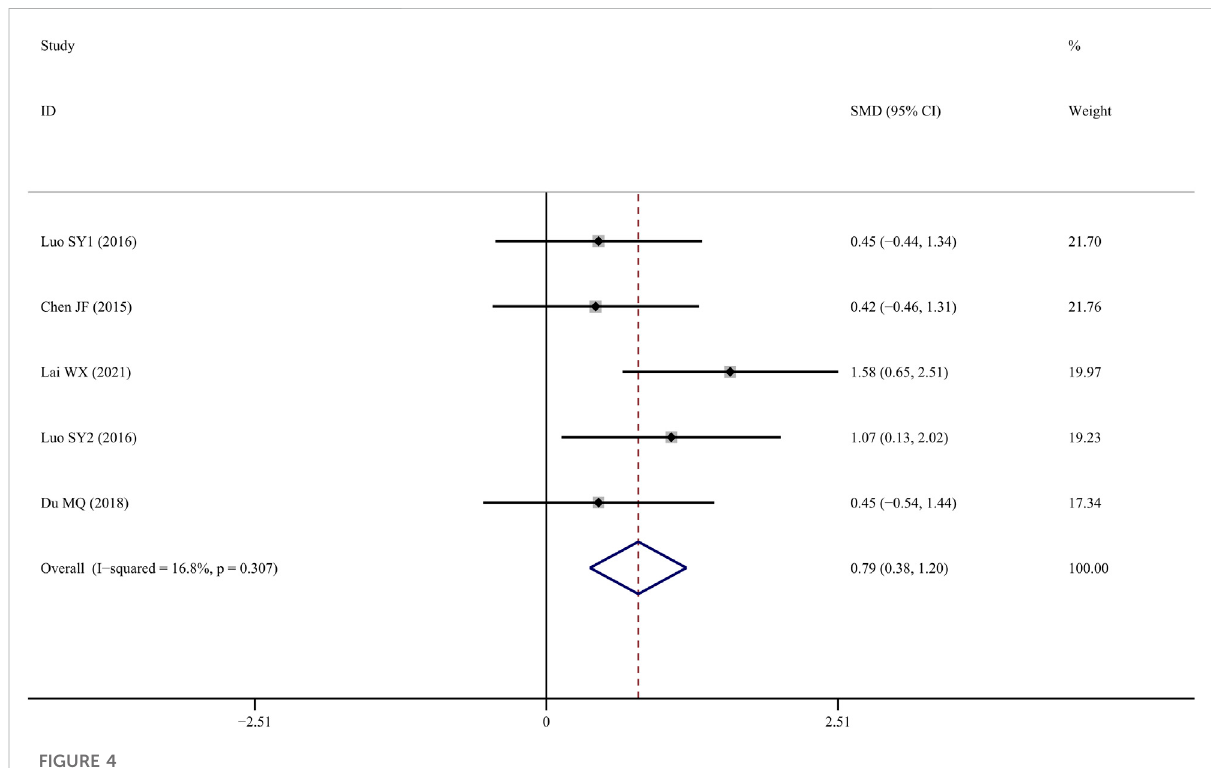
FIGURE 4 Effect of tanshinol on BV/TV change in OP